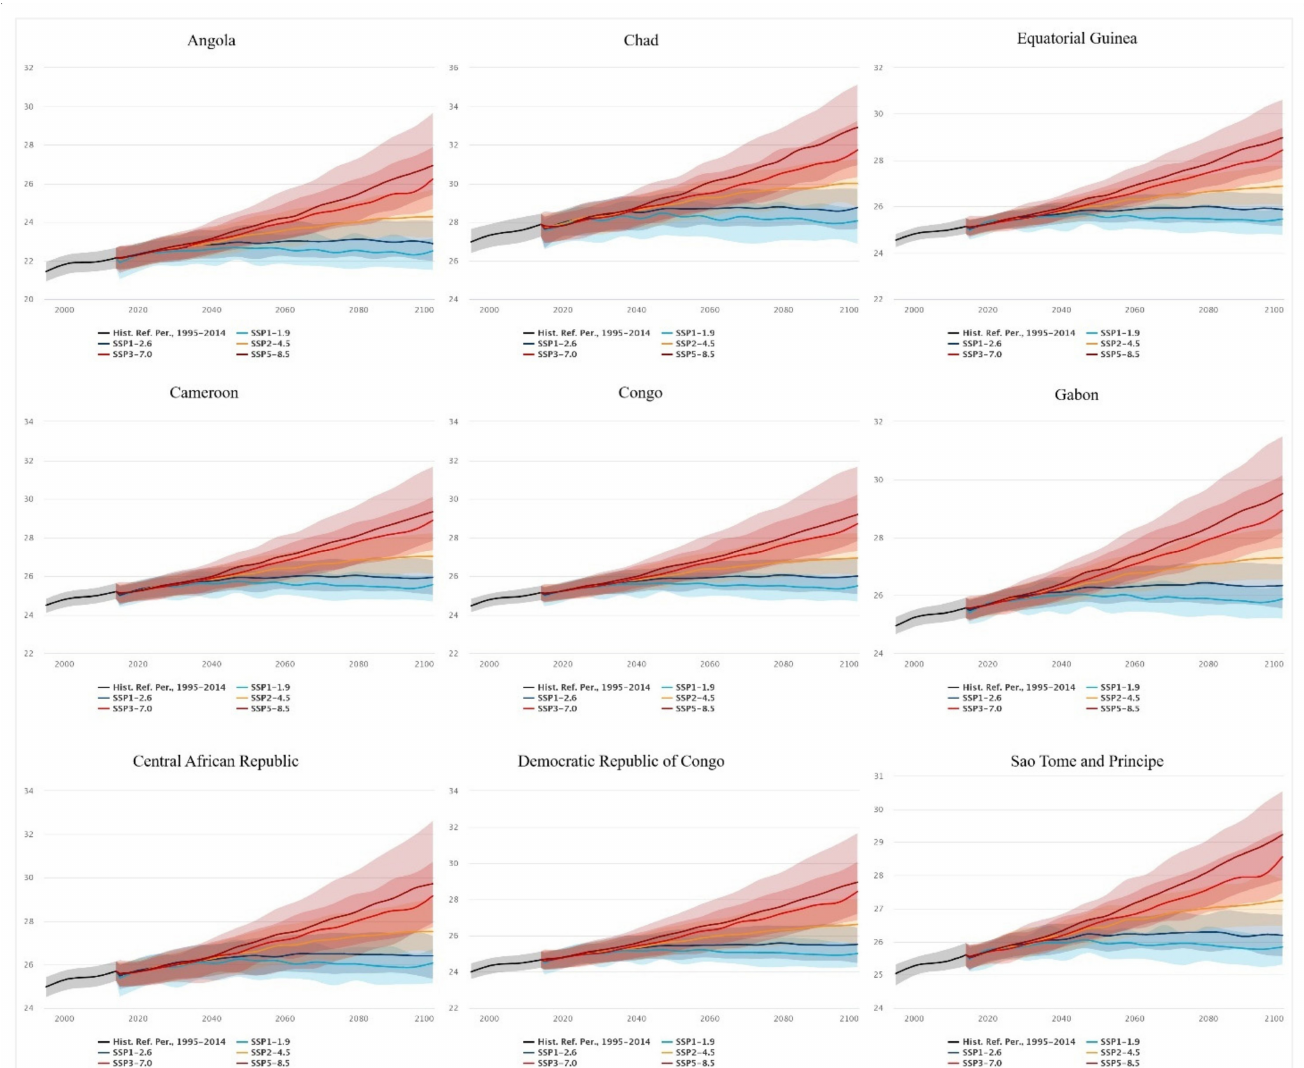
Figure 8. Projected mean air temperature in the Central African Region using a multi-model ensemble with historical reference dated between 1995 and 2014 [43]. Central African Republic, the median prediction for the 2030 low-end range is 25.89 ◦ C (IQR = 24.95, 26.43) and the high-end range is 26.05 ◦ C (IQR = 25.2, 26.71). The estimates for the 2070 low-end range are 26.1 ◦ C (IQR = 25.15, 26.91), whereas the high-end range is 27.96 ◦ C (IQR = 25.92, 29.54). The low-end range prediction for 2100 is 26.07 ◦ C (IQR = 25.15, 26.72), and the high-end range prediction is 29.72 ◦ C (IQR = 27.92, 32.61) (Figure 8). Chad’s low-end range prediction for 2030 is 28.07 ◦ C (IQR = 26.92, 28.75), whereas the high-end range is 28.37 ◦ C (IQR = 27.47, 29.11). For the year 2070, the low-end range is 28.27 ◦ C (IQR = 26.89, 29.15) and the high-end range is 30.59 ◦ C (IQR = 29.05, 32.11). In 2100, the low-end range prediction is 28.06 ◦ C (IQR = 26.87, 28.76) whereas the high-end range is 32.9 ◦ C (IQR = 30.94, 35.12) (Figure 8). For 2030, Congo’s low-end range is 25.45 ◦ C (IQR = 24.8, 25.97), and the high-end range prediction is 25.59 ◦ C (IQR = 25.04, 26.17). For 2070, the low-end range prediction is 25.53 ◦ C (IQR = 24.85, 26.21) and the high-end range is 27.44 ◦ C (IQR = 26.28, 28.96). In 2100, the low-end range prediction is 25.49 ◦ C (IQR = 24.68, 26), while the high-end range prediction is 29.19 ◦ C (IQR = 27.82, 31.65) (Figure